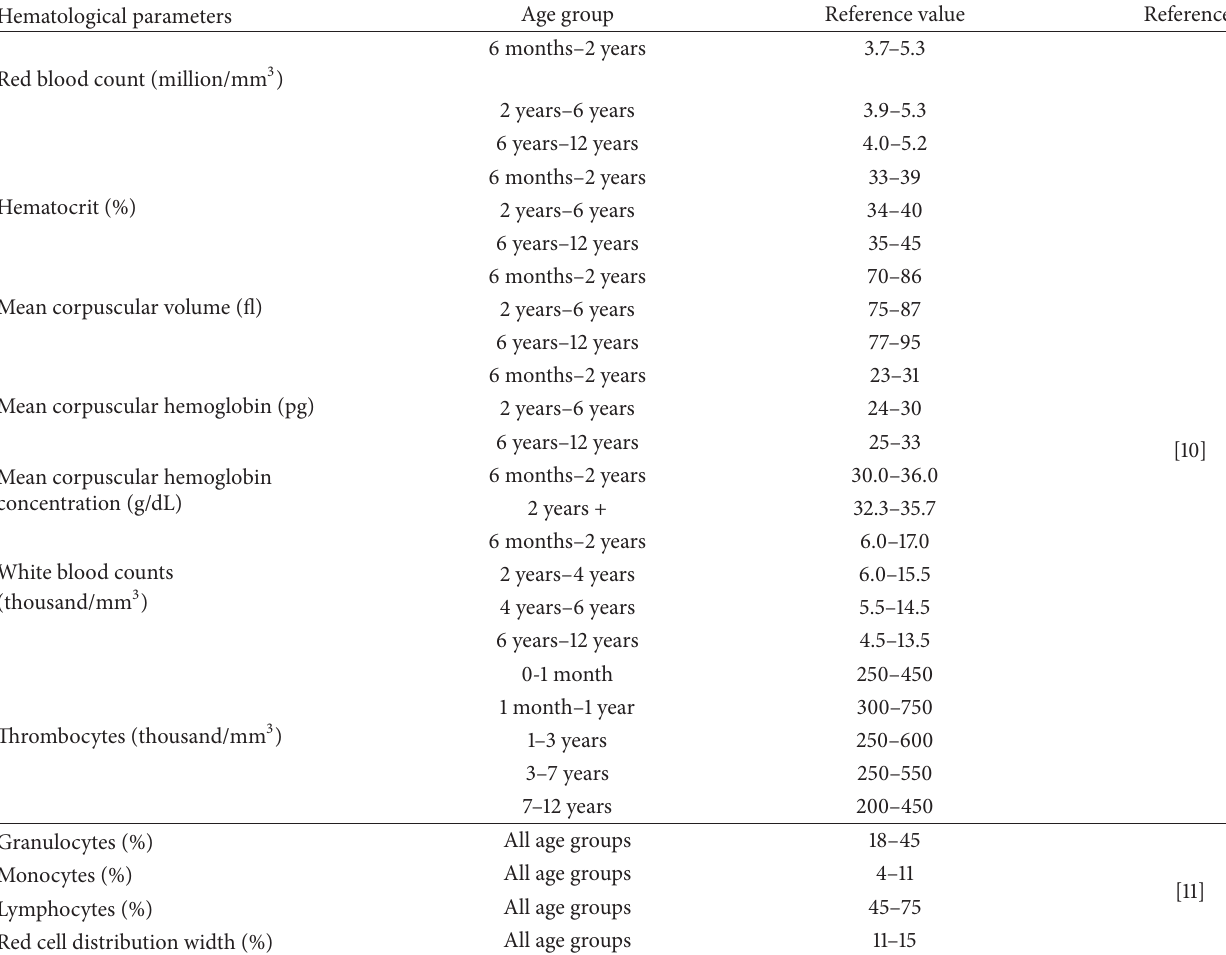
Table 2: Reference range/cut-off values assigned for different hematological